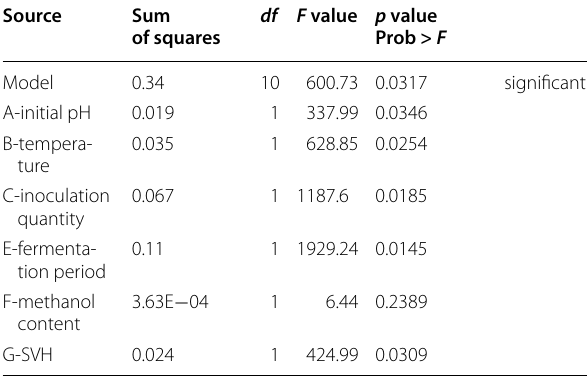
Table 3 Analysis of variance (ANOVA) for Plackett–Burman